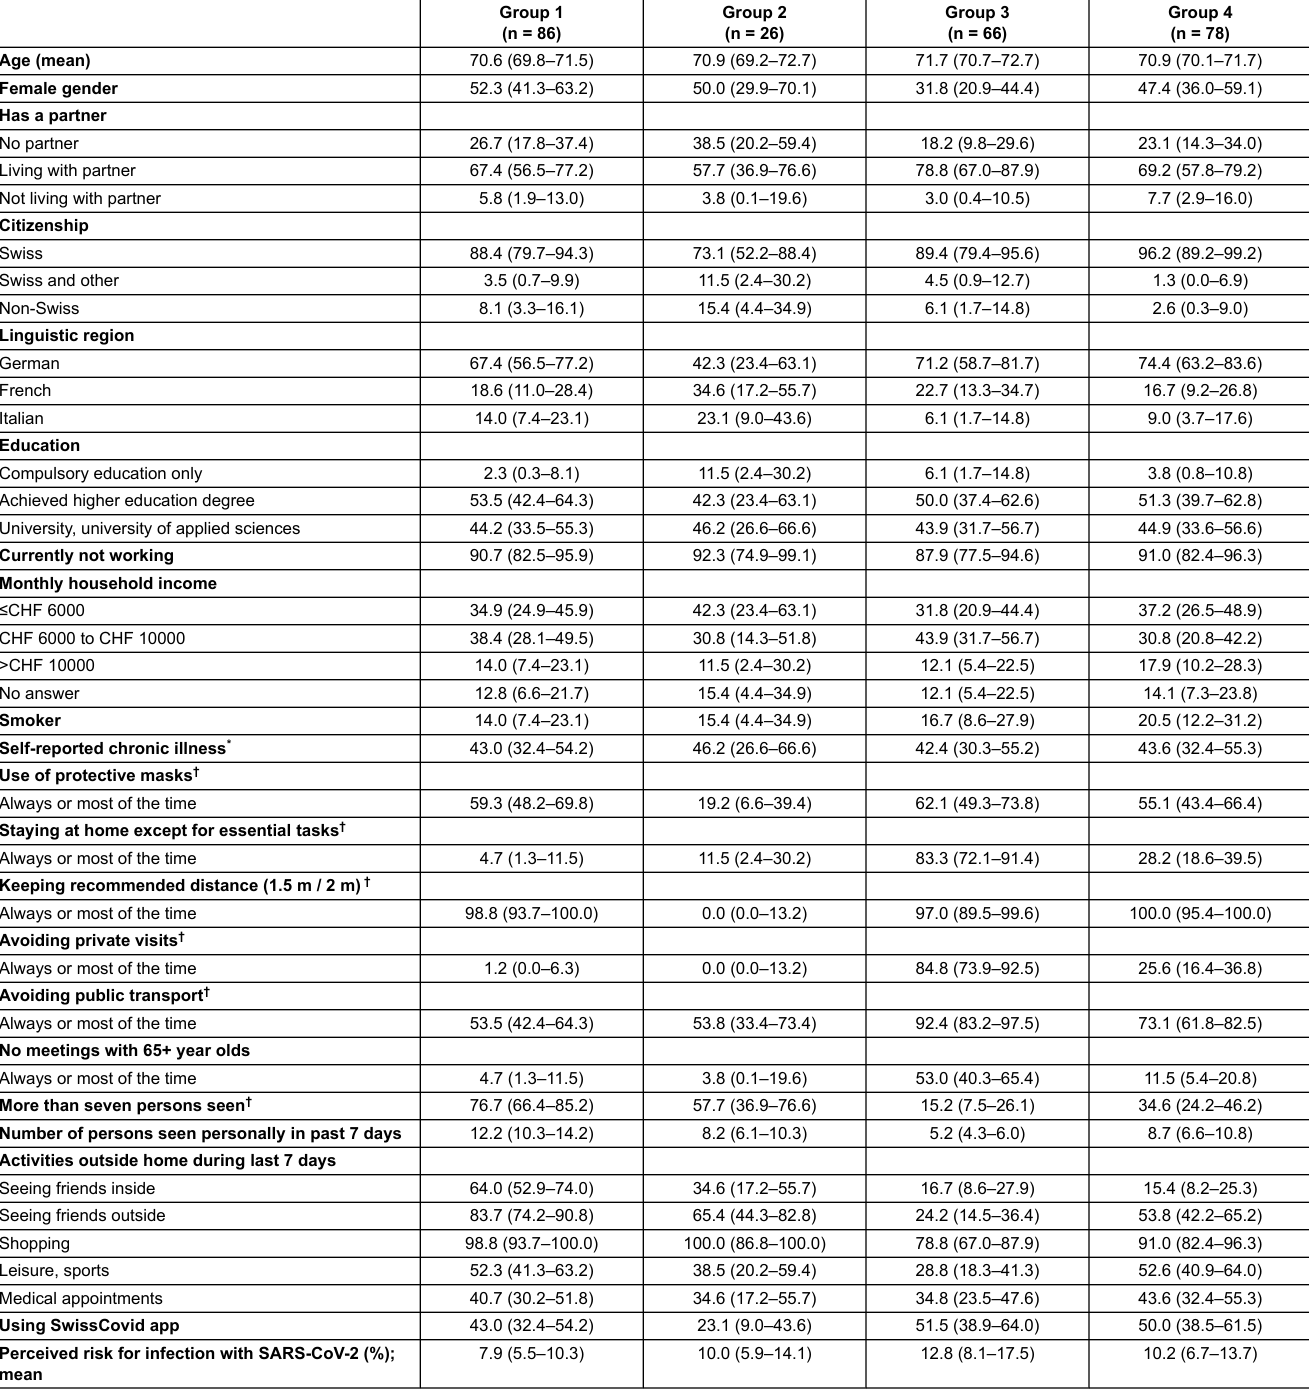
Table 2: Demographic characteristics of four distinct groups of elderly persons with regard to their adherence to recommended preventive measures derived from an exploratory factor